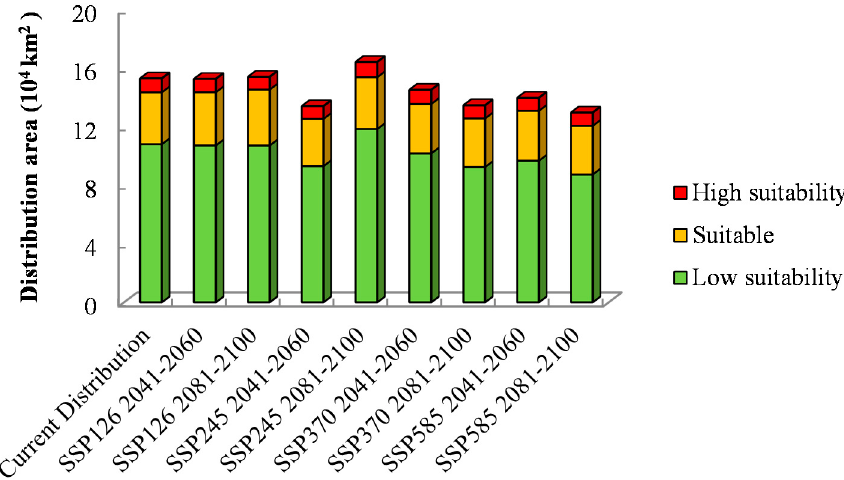
Figure 4. The area of suitable habitat of S. moorcroftiana under current and future climate